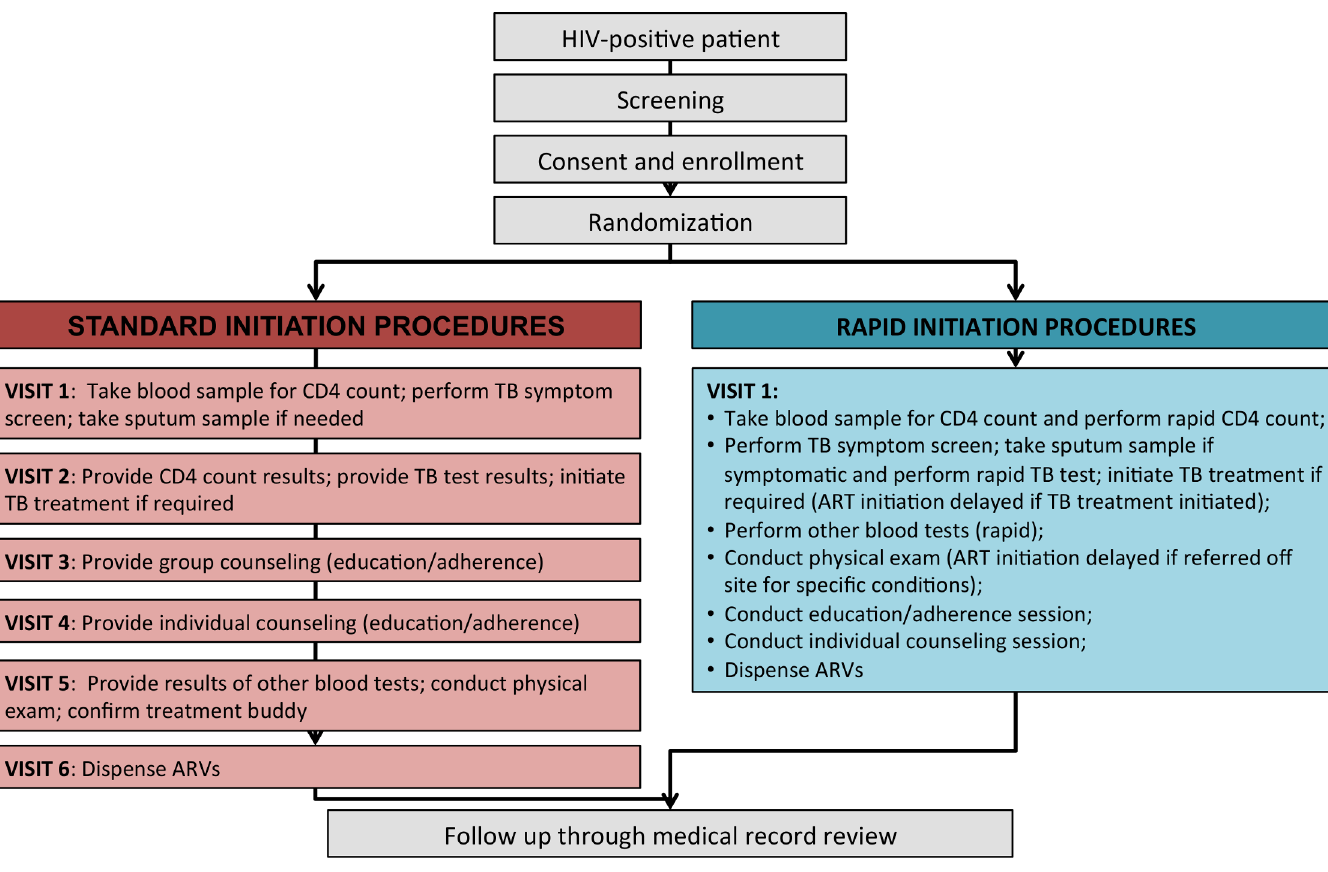
Fig 1. Standard initiation of treatment and rapid initiation procedures and visit